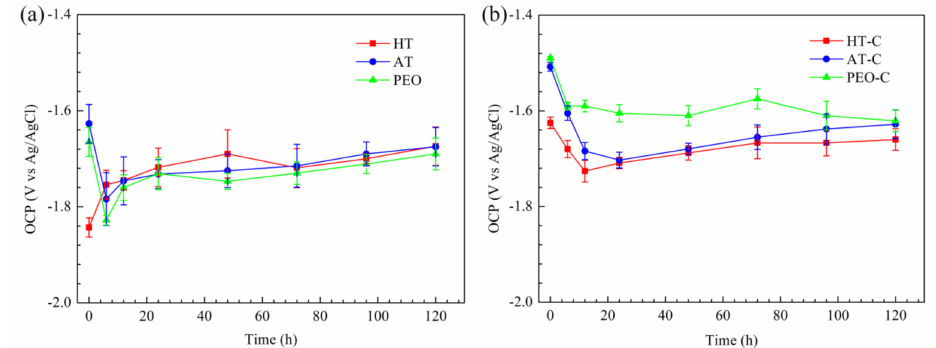
Figure 7. Open circuit potential— t curves of the pre-treated substrates and CaPh-coated samples in SBF at 37 ± 0.5 ◦ C: ( a ) pre-treated substrates; ( b ) CaPh-coated